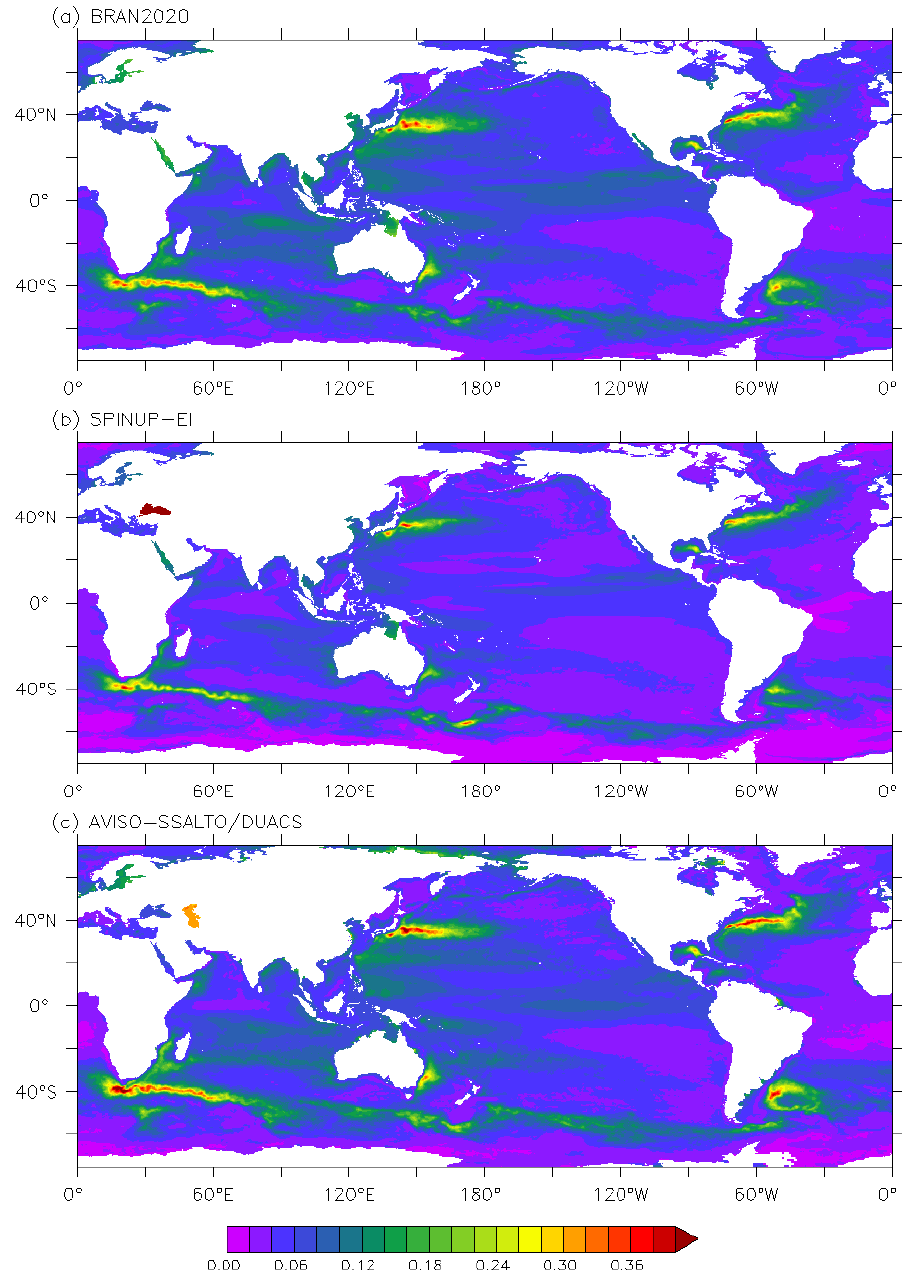
Figure 9. Sea-level variability over 1993–2014 (detrended) from BRAN2020 (a) , a model without data assimilation (b) and observations (c)